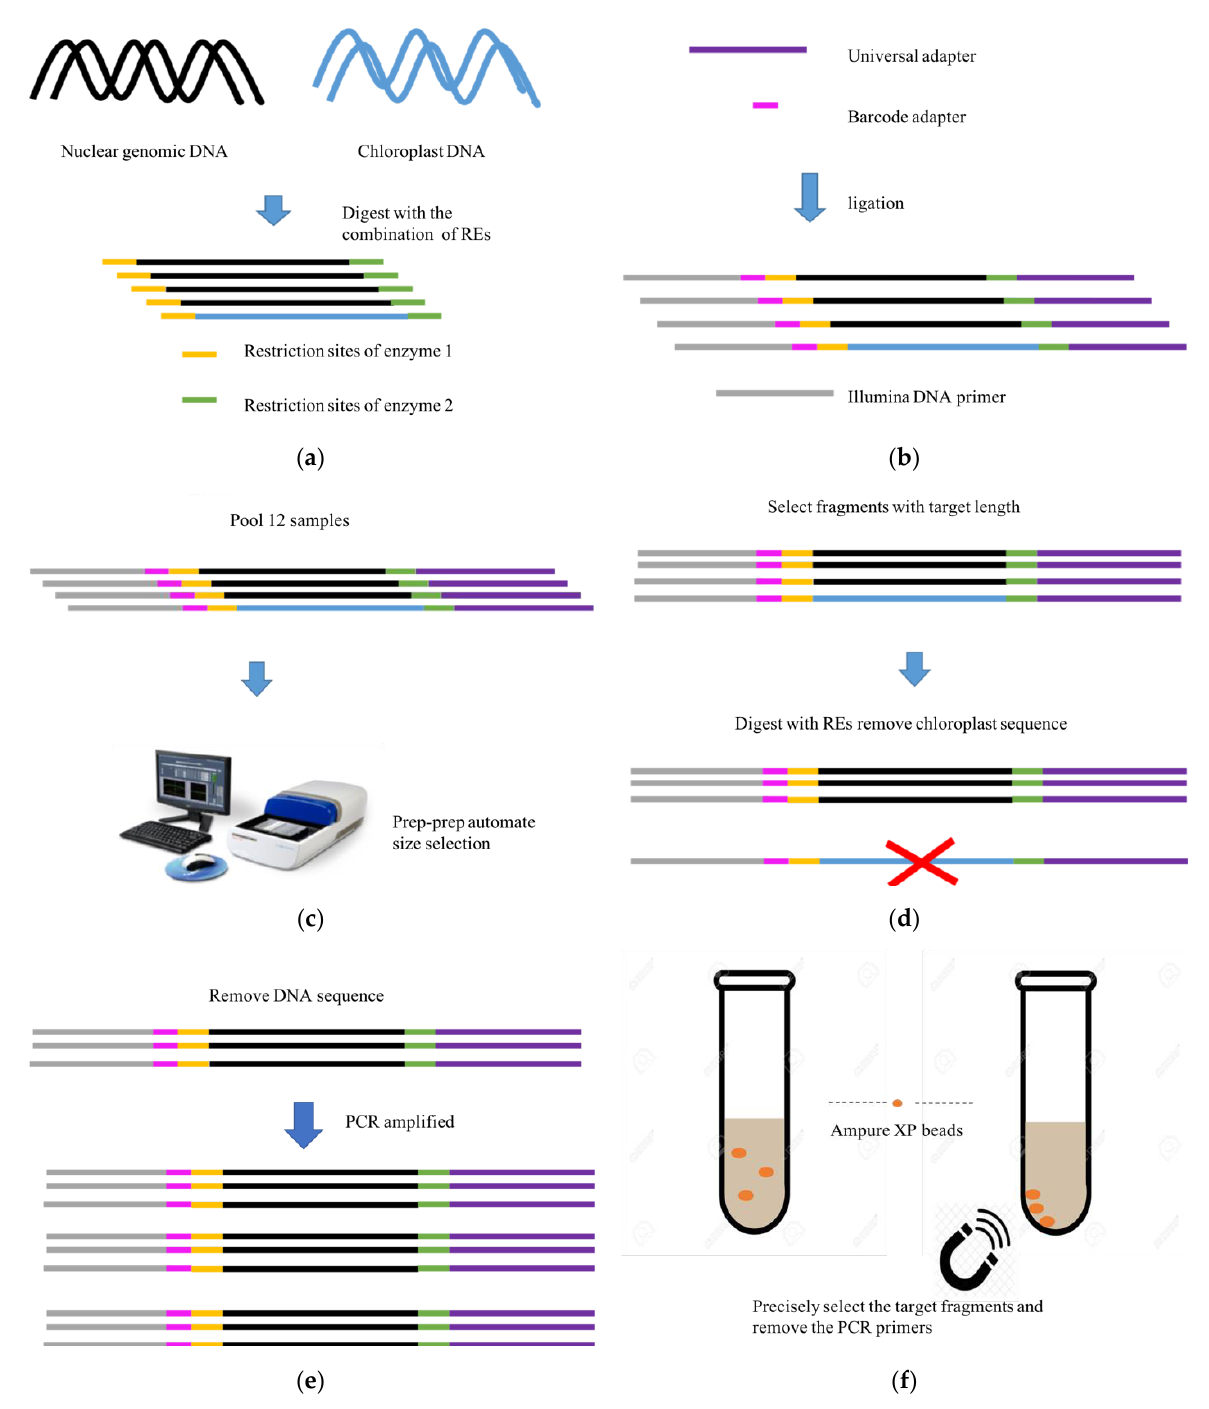
Figure 4. Diagrammatic workflow of the optimizing RAD-seq library construction in the present study. ( a ) Digesting genomic DNA into DNA fragments with designed lengths. ( b ) Adding adapters on both sides of the selected DNA fragments. ( c ) The first round of fragment size selection with Pippin prep. ( d ) The second digestion to remove DNA fragments from the chloroplast genome and/or RNA genes. ( e ) PCR amplification. ( f ) The second round of fragment size selection with Ampure XP beads.